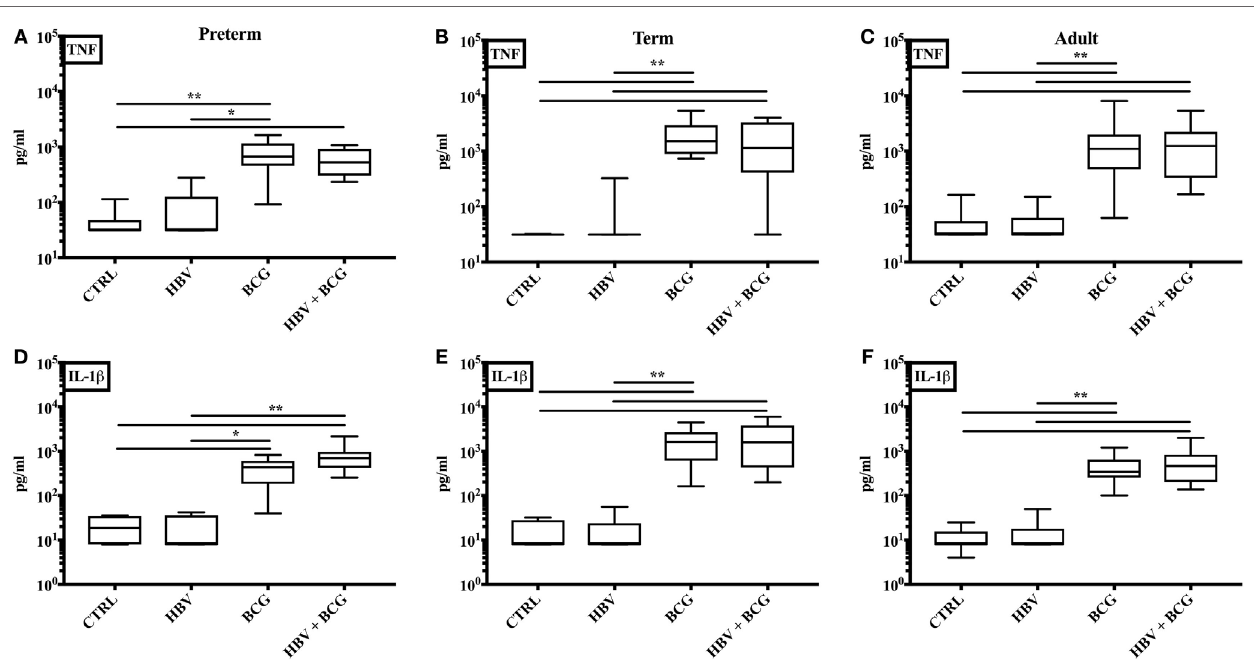
FigUre 1 | Concurrent stimulation with [Bacille Calmette–Guérin (BCG) + hepatitis B vaccine (HBV)] synergistically enhances IL-1 β production in human preterm, term, and adult whole blood. Preterm (a, D) , term (B, e) , and adult (c, F) whole blood was stimulated with HBV alone, BCG alone, or (BCG + HBV) at 1:10 v/v. After 6 h, supernatants were analyzed for TNF (a–c) and IL-1 β (D–F) cytokine production by ELISA. Statistical significance was determined by Kruskal–Wallis with Dunn post hoc test. * p < 0.05, ** p < 0.01. N = 7–8 preterm, N = 10–11 term newborns, and N = 10–11